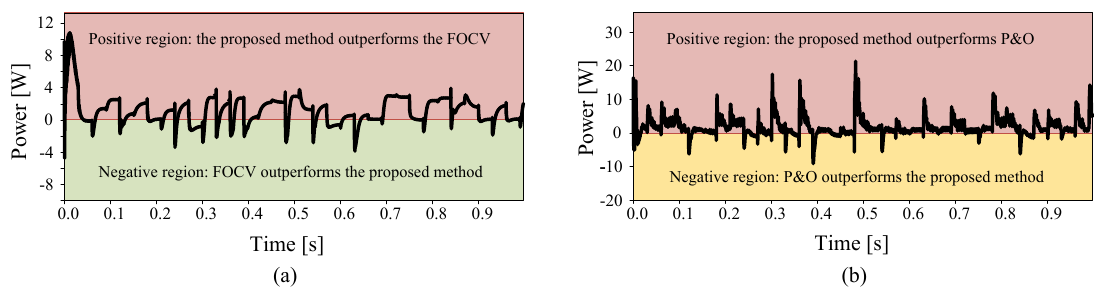
Figure 14. The output waveform of the PV panel for Case 1 using various tracking algorithm: ( a ) The performance over a long time period. ( b ) Zoomed area.